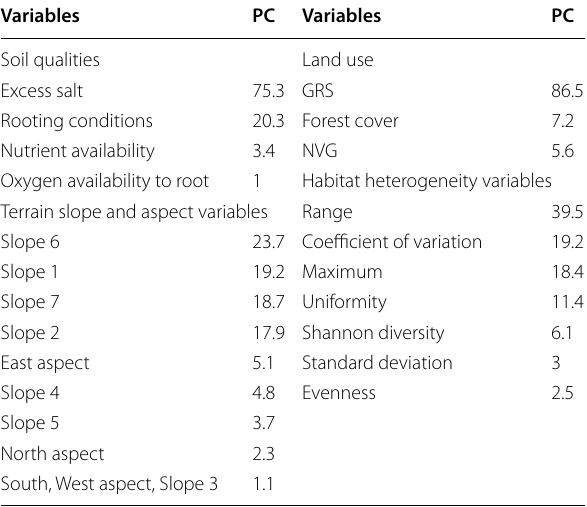
Table 3 Percentage contribution (or variable importance percentage) of various non-bioclimatic variables